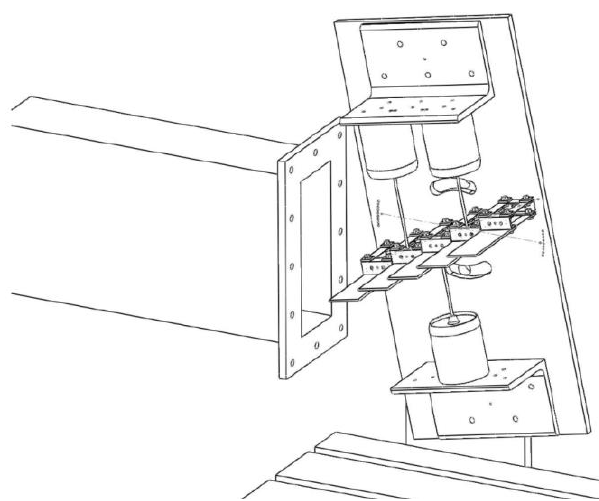
Fig. 2. Experiment